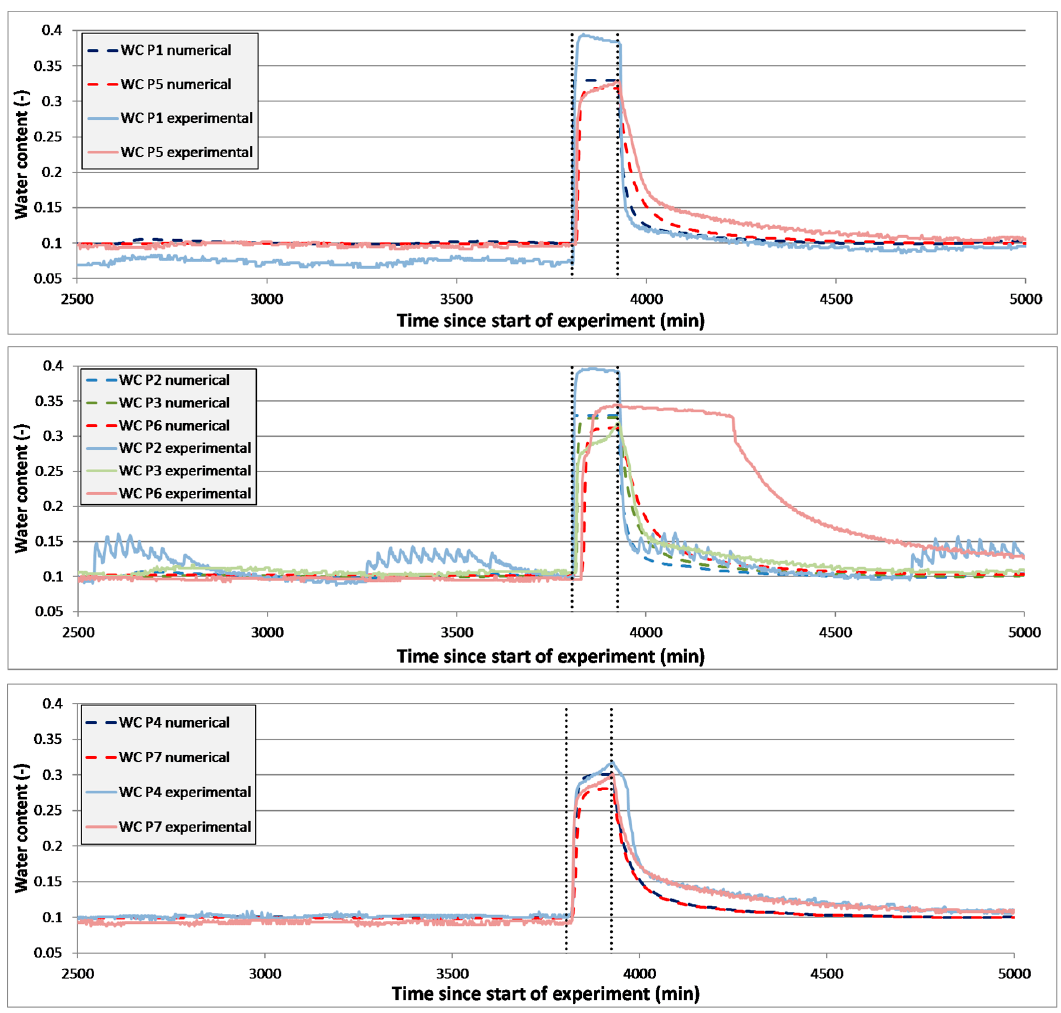
Figure 5. Results for simulation of water contents for scenario WW-RE-Int (jnt.) as compared to observed values in the laboratory tank experiment for the time 2500 to 5000 min. after onset of the numerical experiment, black dotted line indicates duration of precipitation event.